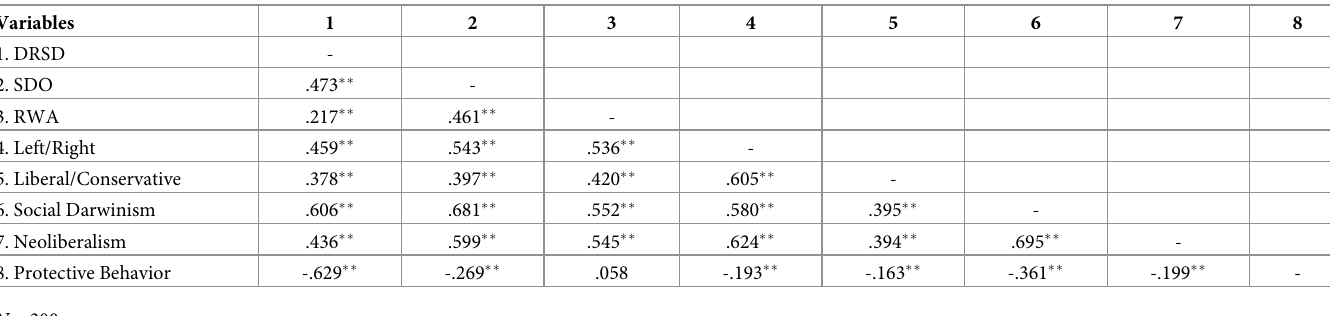
Table 2. Correlations Study 1.